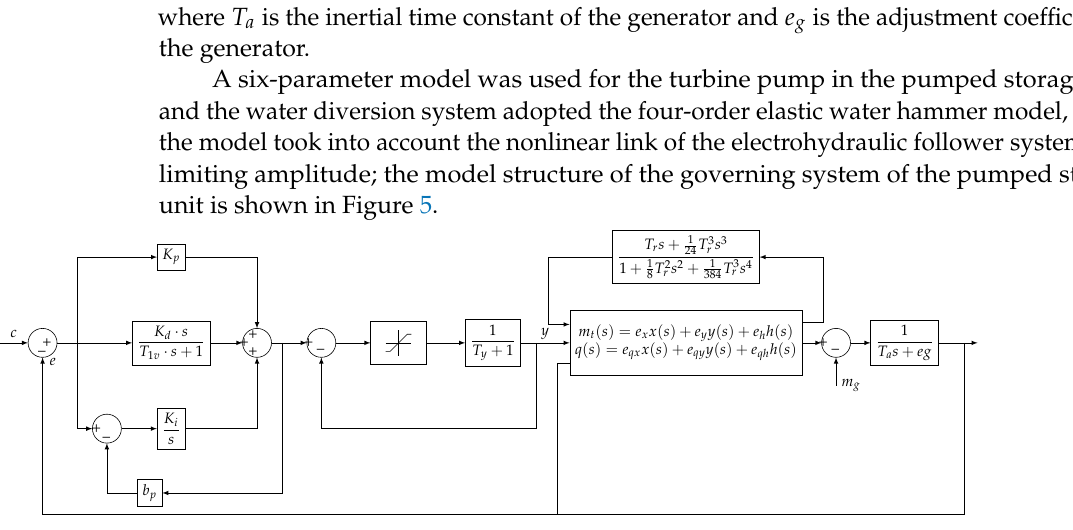
Figure 5. Simulation model of the governing system in the pumped storage